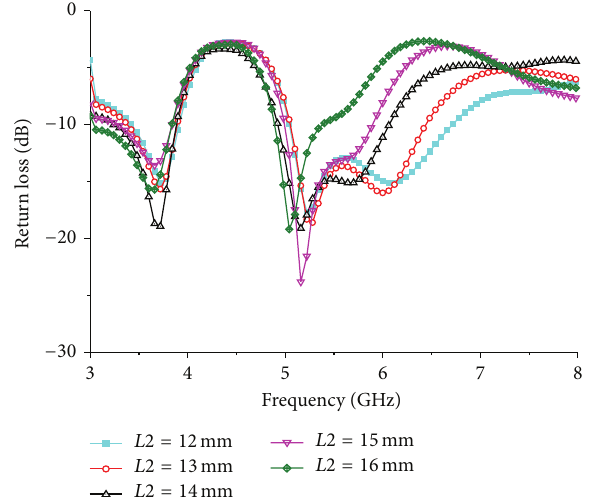
Figure 7: Parametric studies of the stunning stub 𝐿1 .